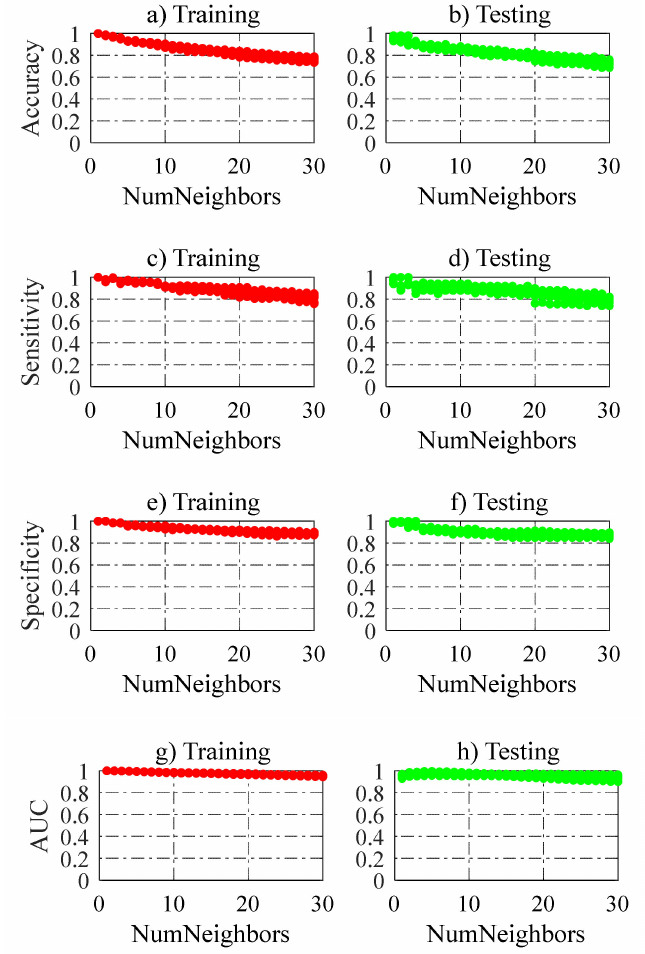
Figure 15. Performance of 210 KNNs models for classifying failure modes.